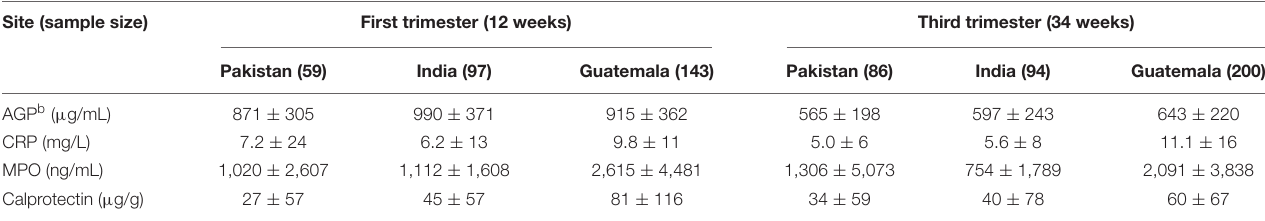
TABLE 6 | AGP, CRP, MPO, and calprotectin in first and third trimester by the site a . Site (sample